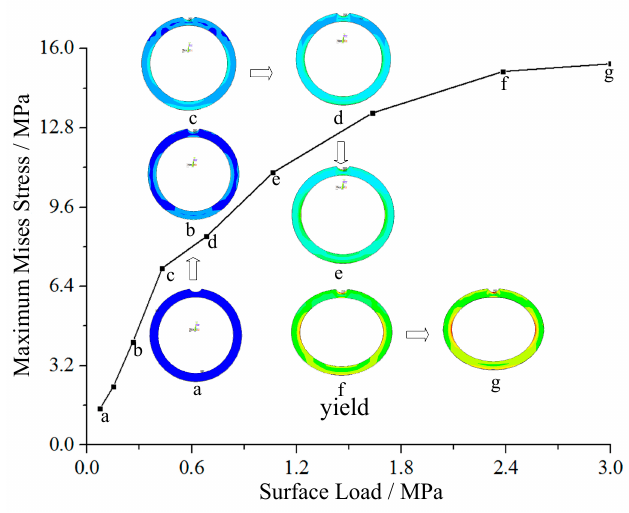
Figure 10. Failure process of HDPE pipe with defects under surface load.